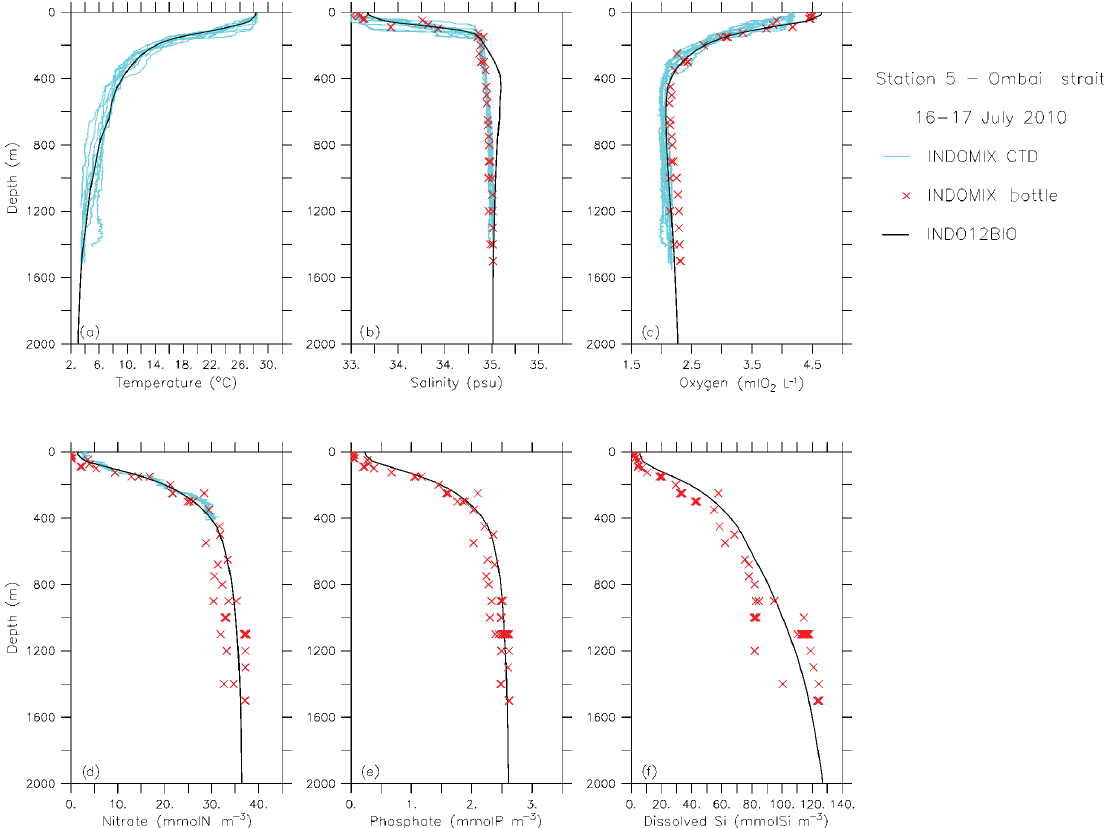
Figure 14. Vertical profiles of temperature ( ◦ C; a ), salinity (psu; b ), oxygen (mLO 2 L − 1 ; c ), nitrate (mmolNm − 3 ; d ), phosphate (mmolPm − 3 ; e ) and dissolved silica (mmolSim − 3 ; f ) concentrations at INDOMIX cruise station 5 (Ombaï Strait; 16–17 July 2010). CTD (light blue lines) and bottle (red crosses) measurements represent the conditions during cruise, 2-day model averages are shown by the black